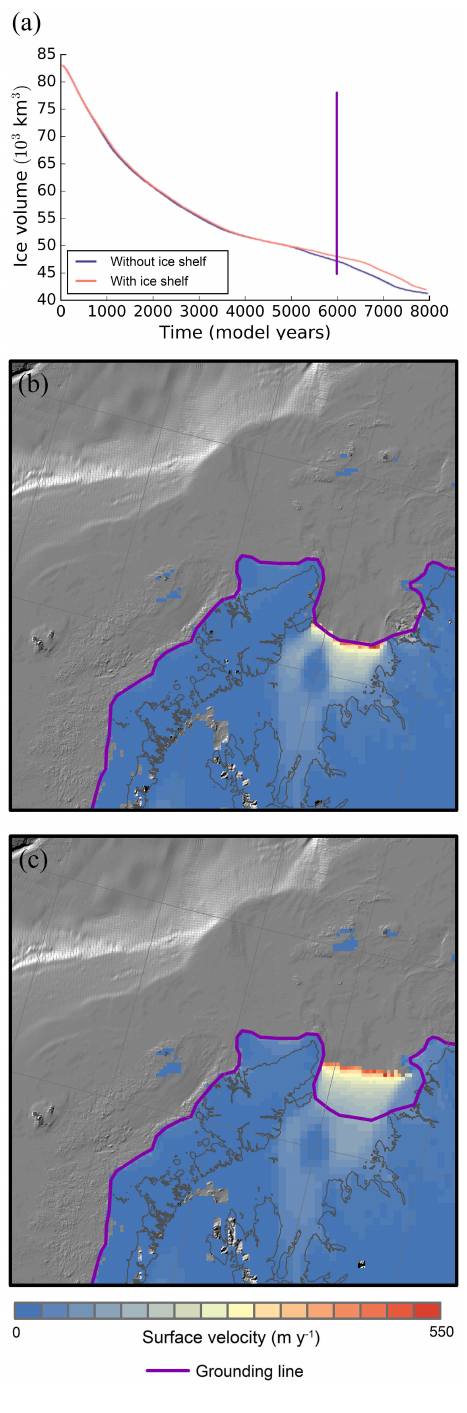
Figure 5. Effect of ice shelves. The contemporary coast is shown as a thin grey line. (a) Evolution of grounded ice sheet volume over the Minch sector in simulation RETREAT with ice shelves (red line) and RETREAT_NOSHELF in which ice shelves are forcibly removed (blue line). (b, c) Surface velocity and grounding line loca- tion (purple line) in RETREAT_NOSHELF (b) and RETREAT (c)